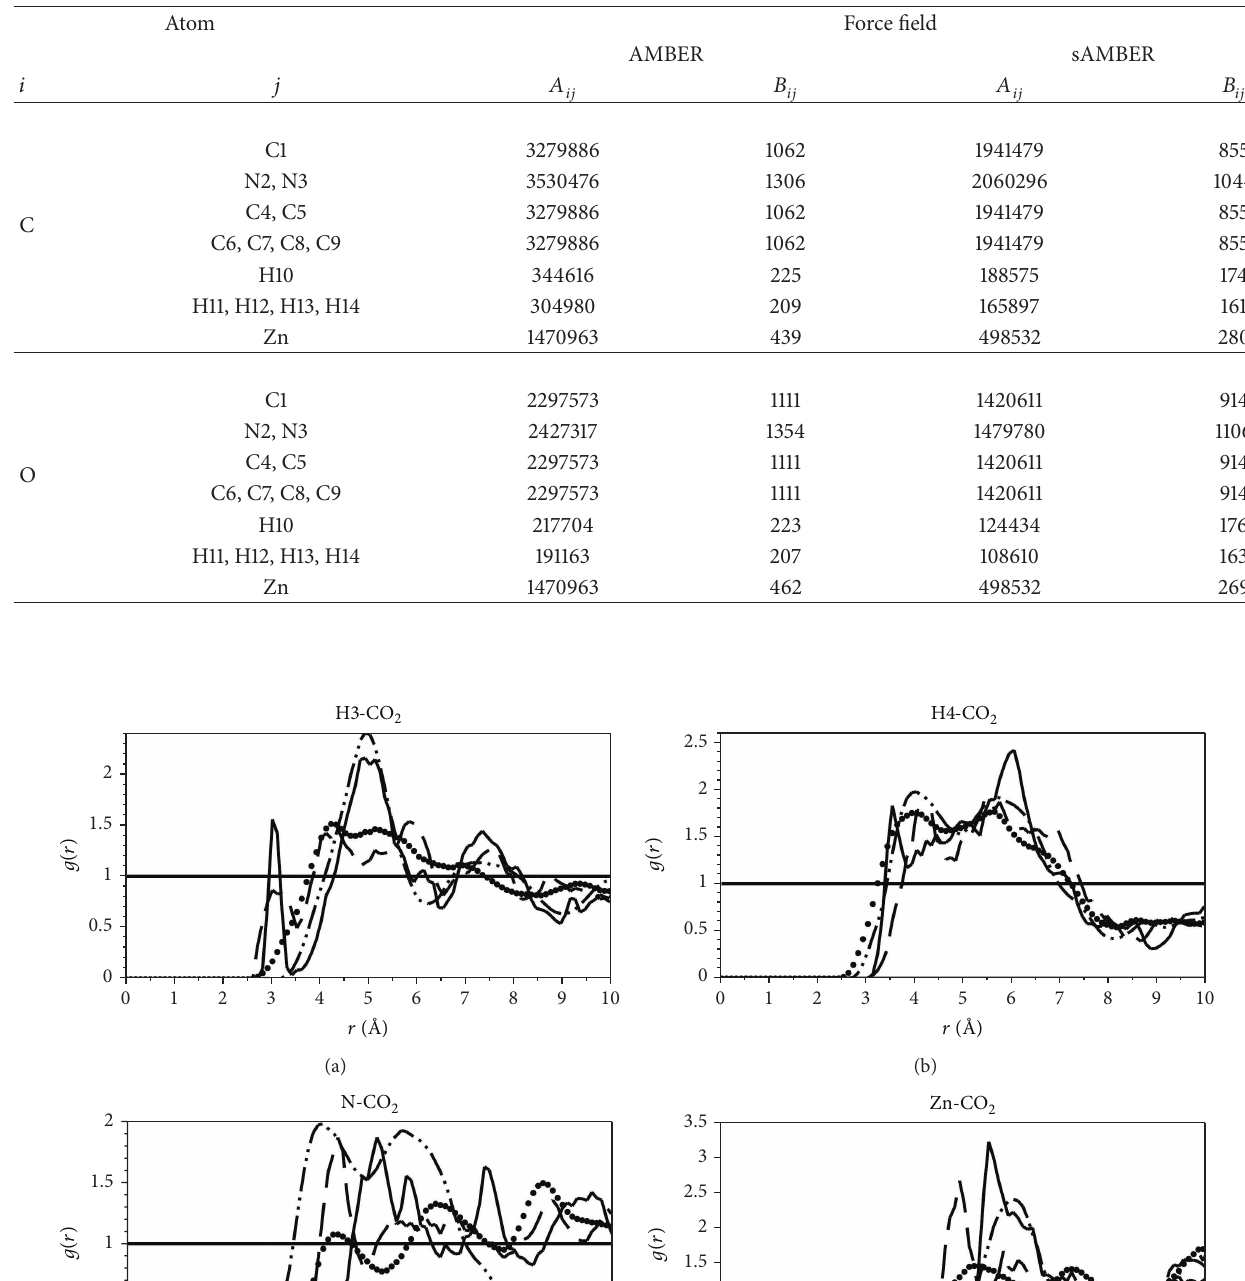
Table 4: The parameters 𝐴 𝑖𝑗 and 𝐵 𝑖𝑗 (kcal/mol) that are obtained from the AMBER and sAMBER force fields.